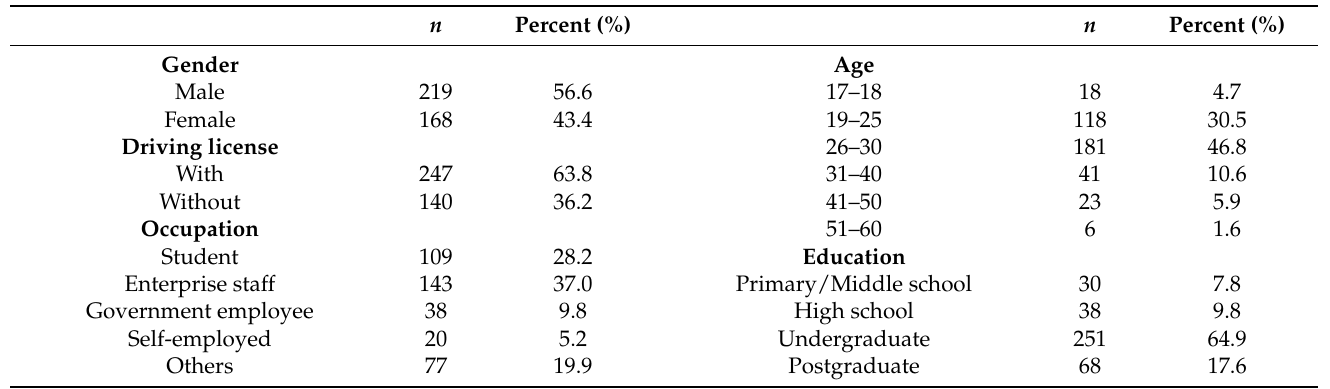
Table 1. Number and percentage of participants by demographic variables ( N =